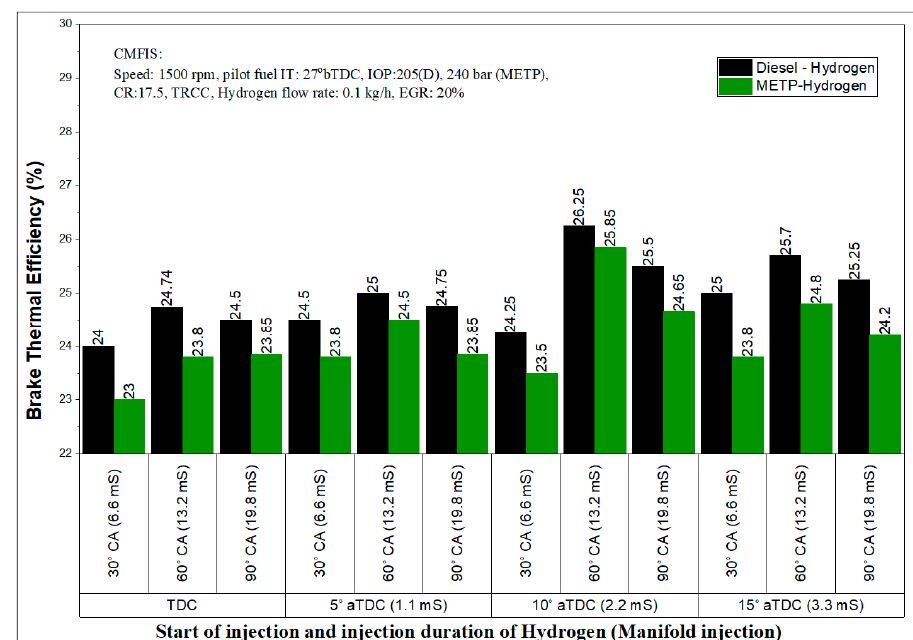
Figure 10. BTE for manifold injection of hydrogen in CMFIS based dual fuel engine.